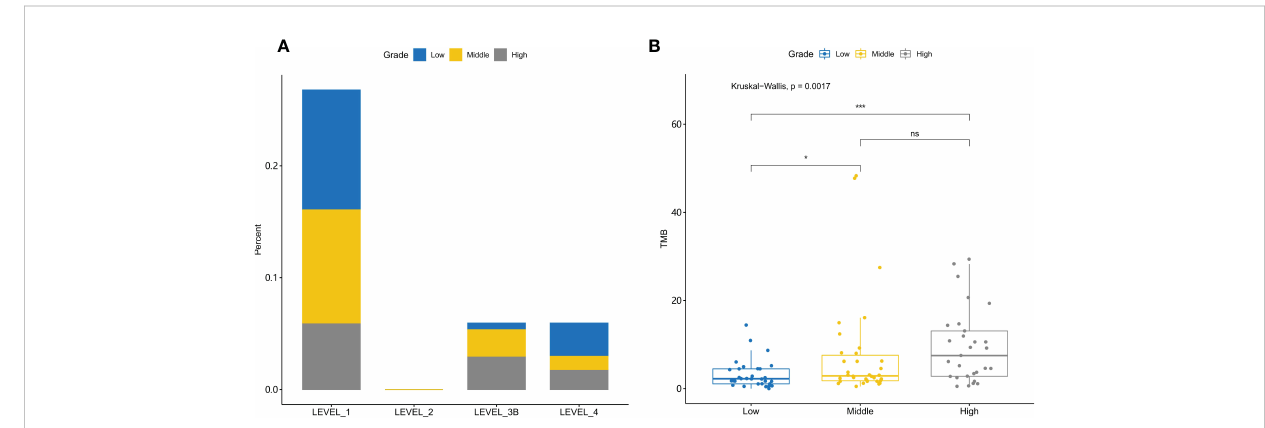
FIGURE 5 Actionability and tumor mutational burden are different for low-, middle-, and high-grade tumors (A) The evidence levels of actionability in lung cancers are shown for different grades of tumors. (B) Tumor mutational burden (TMB) is signi fi cantly different among different grades of tumors.